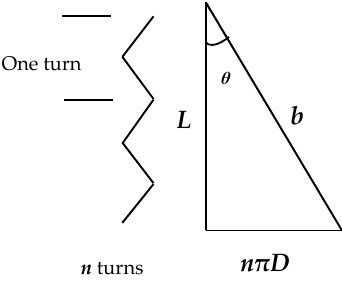
Figure 2. The parameters of the PMA.